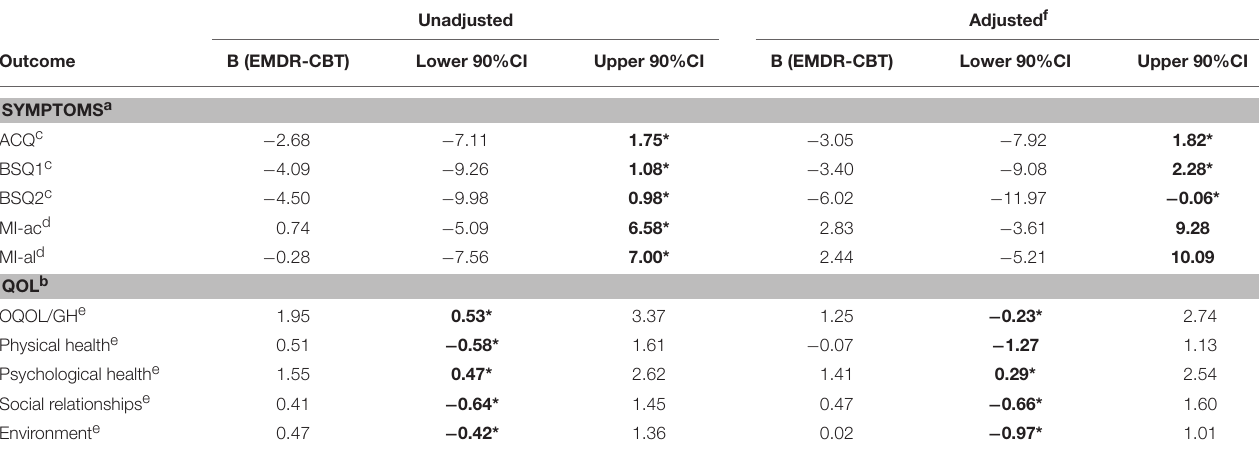
TABLE 3 | Non-inferiority effects EMDR vs. CBT at